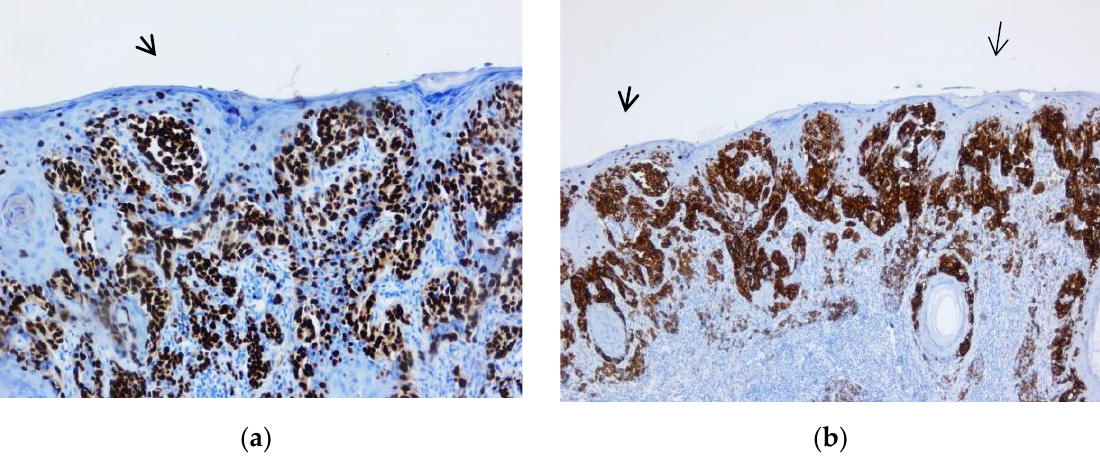
Figure 7. Nevoid melanoma. ( a ) IHC staining with SOX10 (10× magnification). ( b ) IHC staining with Melan-A (5× magnification). Pagetoid migration is observed, and tumor cells reach the corneous layer (arrows). (Collection of Pathology Department SCJ Mure ș ).